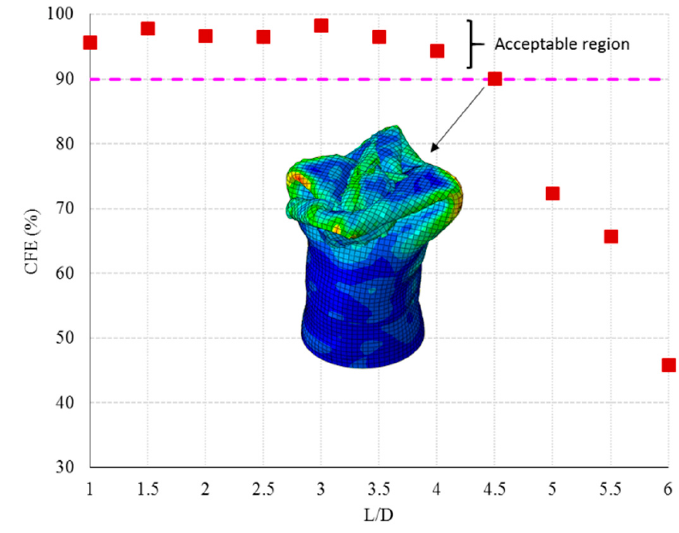
Figure 8. Presentation of L/D influence on the CFE factor.